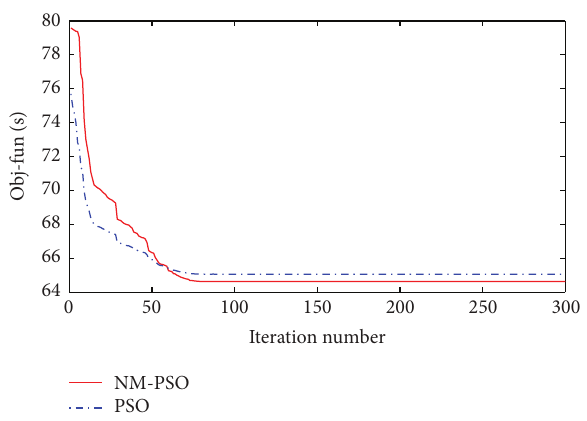
Figure 3: Convergence characteristics of a conventional PSO and the proposed NM-PSO in variable network